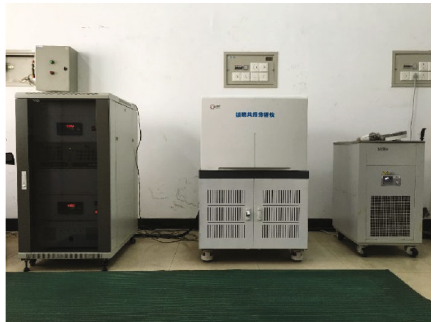
Figure 6: Core NMR analyzer.